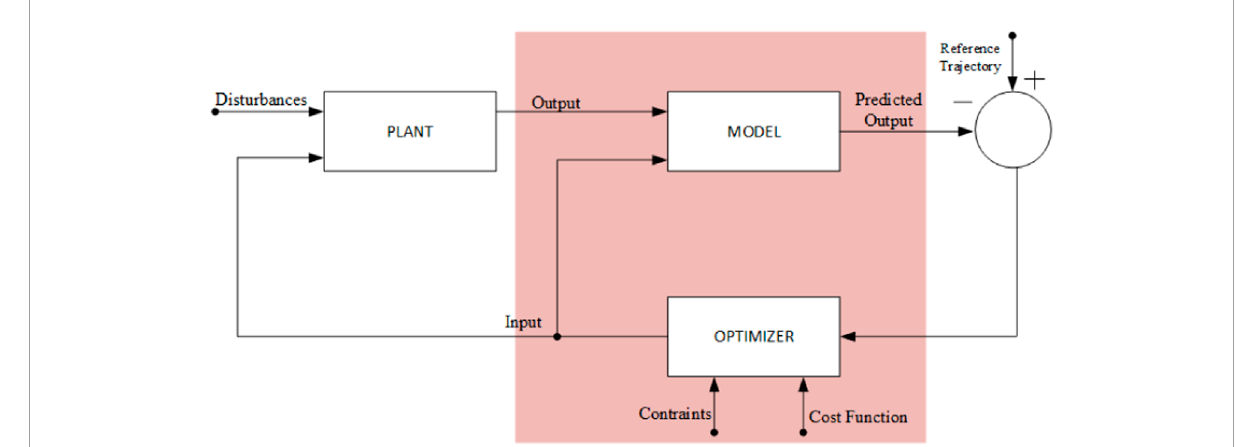
FIGURE 11 MPC block diagram.